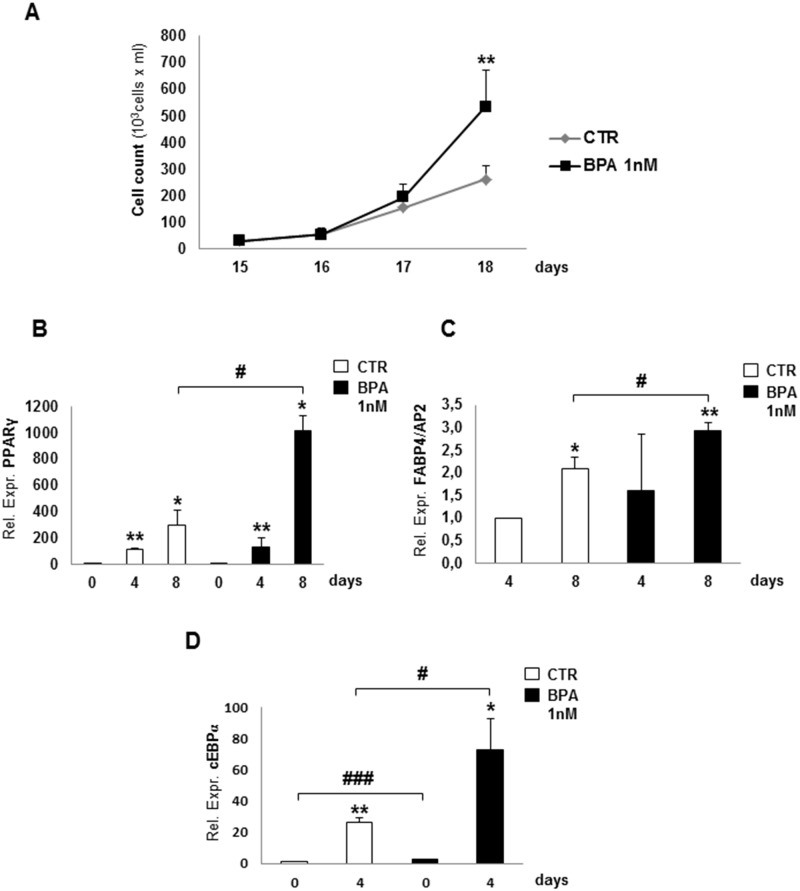
Effect of BPA on 3T3-L1 proliferation and mRNA gene expression.(A) 3T3-L1 pre-adipocyte were counted and expressed as cells/ml, at days 15, 16, 17 and 18, after 2 weeks of incubation with (BPA) or without (CTR) BPA 1nM, before adipogenesis started. PPARγ (B), FABP4/AP2 (C) and cEBPα (D) mRNA levels were assayed during adipogenesis at days 0, 4 and 8, by Real-time RT-PCR analysis, expressed as Relative Expression Unit (REU). Bars represent the mean ± SD of four independent experiments. Asterisks indicate statistically significant differences (*p<0.05; **p<0.01; ***p<0.001) at days 4 and 8 compared to untreated day 0 for PPARγ (B), at day 8 compared to untreated day 4 for FABP4/AP2 (C), and at day 0 and day 4 compared to untreated day 0 for cEBPα (D), without or with BPA incubation. Hashes (# p< 0.05; ### p<0.001) express statistically significant differences between day 8 with or without BPA incubation (B and C) and between day 0 and day 4 with or without BPA incubation (D).